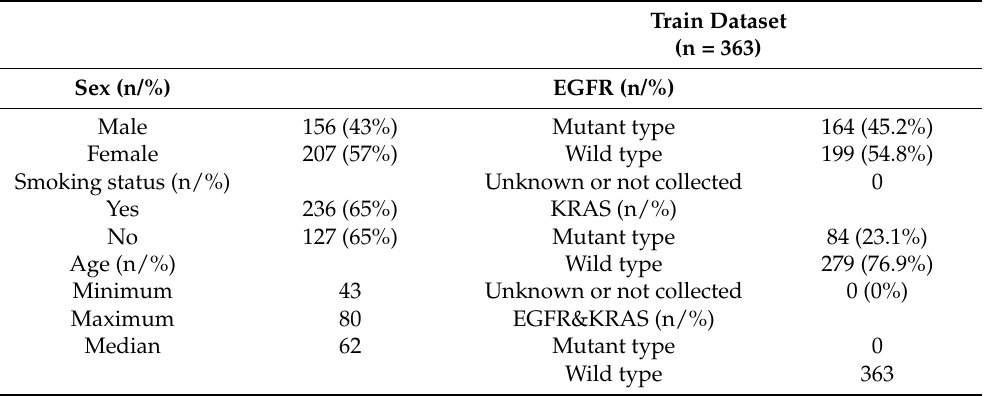
Table 1. The clinical characteristics of the training dataset.